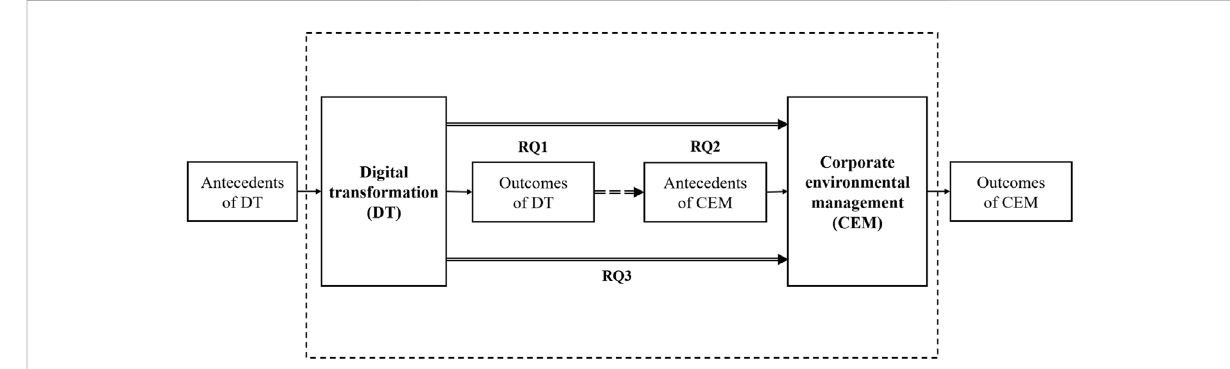
FIGURE 1 Analysis framework of research questions.